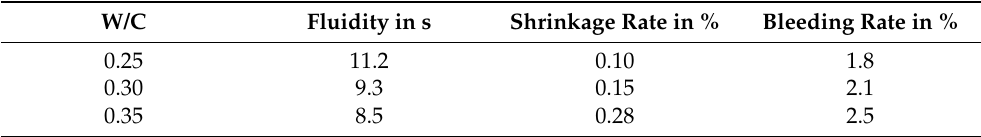
Table 2. Fluidity, shrinkage rate and bleeding rate at different w/c